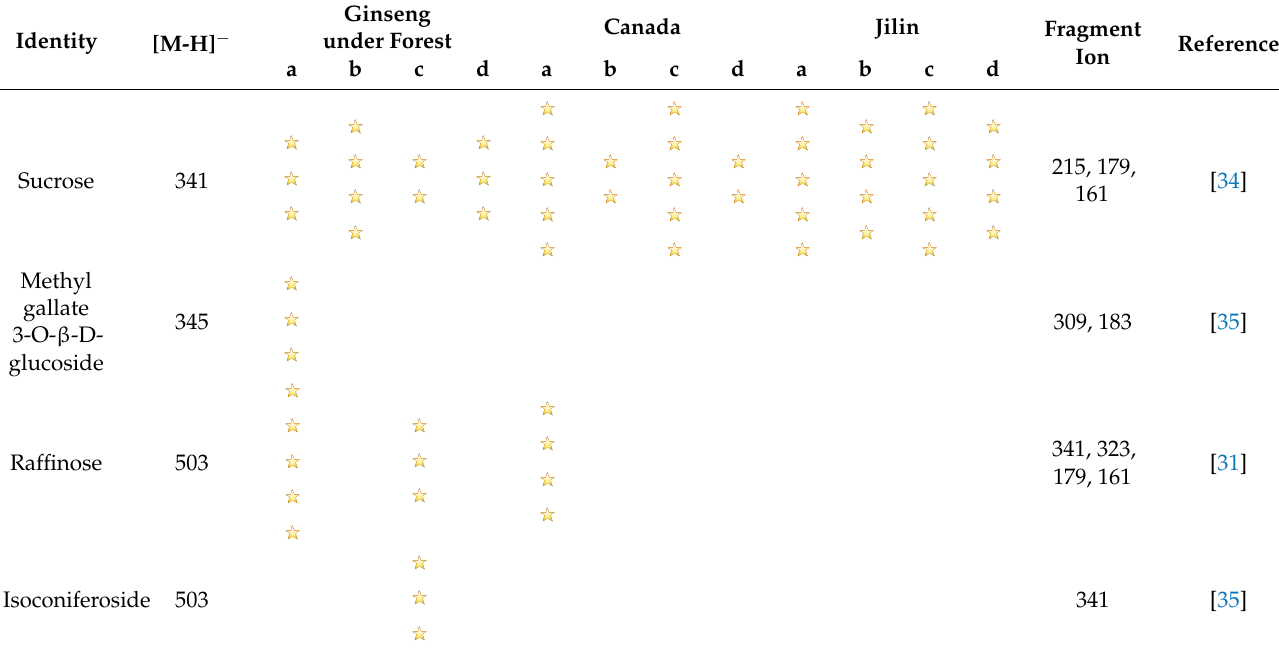
Note: In the table, a, b, c, and d refer to 0.5 mM ammonium chloride in methanol, 0.1% formic acid in water/ethanol ( v : v = 1:1), 10 mM ammonium acetate in acetonitrile/methanol ( v : v = 1:1), and 0.1% formic acid in acetonitrile/ethanol ( v : v = 1:1), respectively. symbols are used to represent the sig- nal strength, where the more symbols there are, the better the signal. represents a signal strength of 10 1 – 10 2 , represents a signal strength of 10 2 – 10 3 , represents a signal strength of 10 4 – 10 5 , and